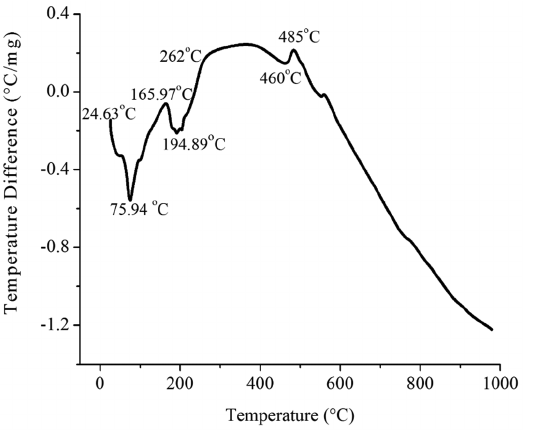
Figure 7. DSC curve of LCHB crystal.